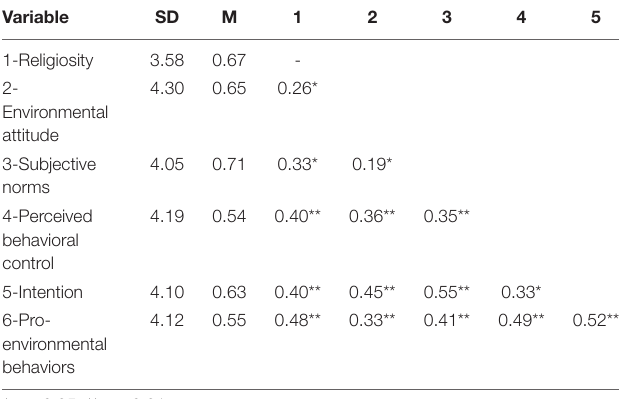
TABLE 2 | Correlations, means, and standard deviation of variables in the study.